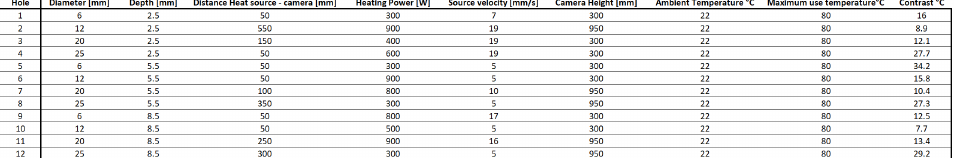
Figure 10. Optimal parameter sets found for the holes in the flat bottom hole sample. The ambient room temperature is 22 ◦ C and the maximum use temperature is chosen at 80 ◦ C. This is not the maximum use temperature of PVC, but it limits the cooling time the sample needs before performing a consecutive measurement. As the temperature difference is used as a measure of contrast, this limitation of the maximum temperature causes no problems. Next to the optimal parameter values for each parameter, the predicted temperature difference is calculated. This contrast is calculated between the sound area and the area above the defect.